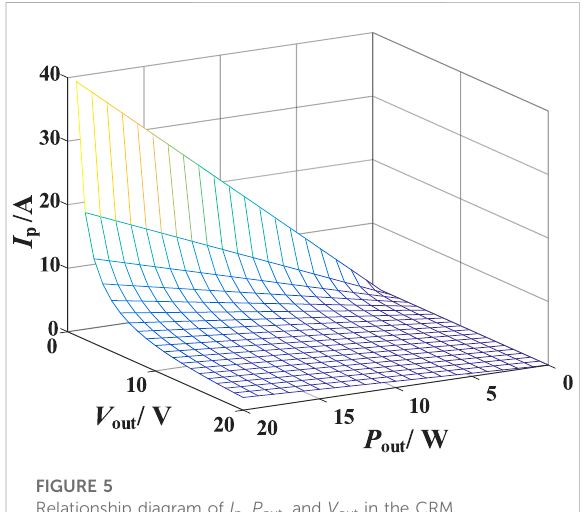
FIGURE 5 Relationship diagram of I p , P out , and V out in the CRM.